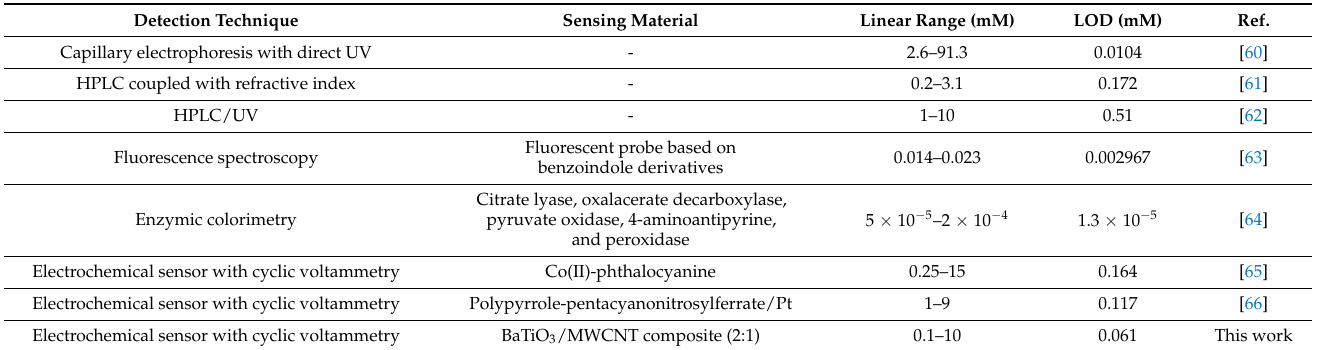
Table 3. Performance of various techniques in citric acid